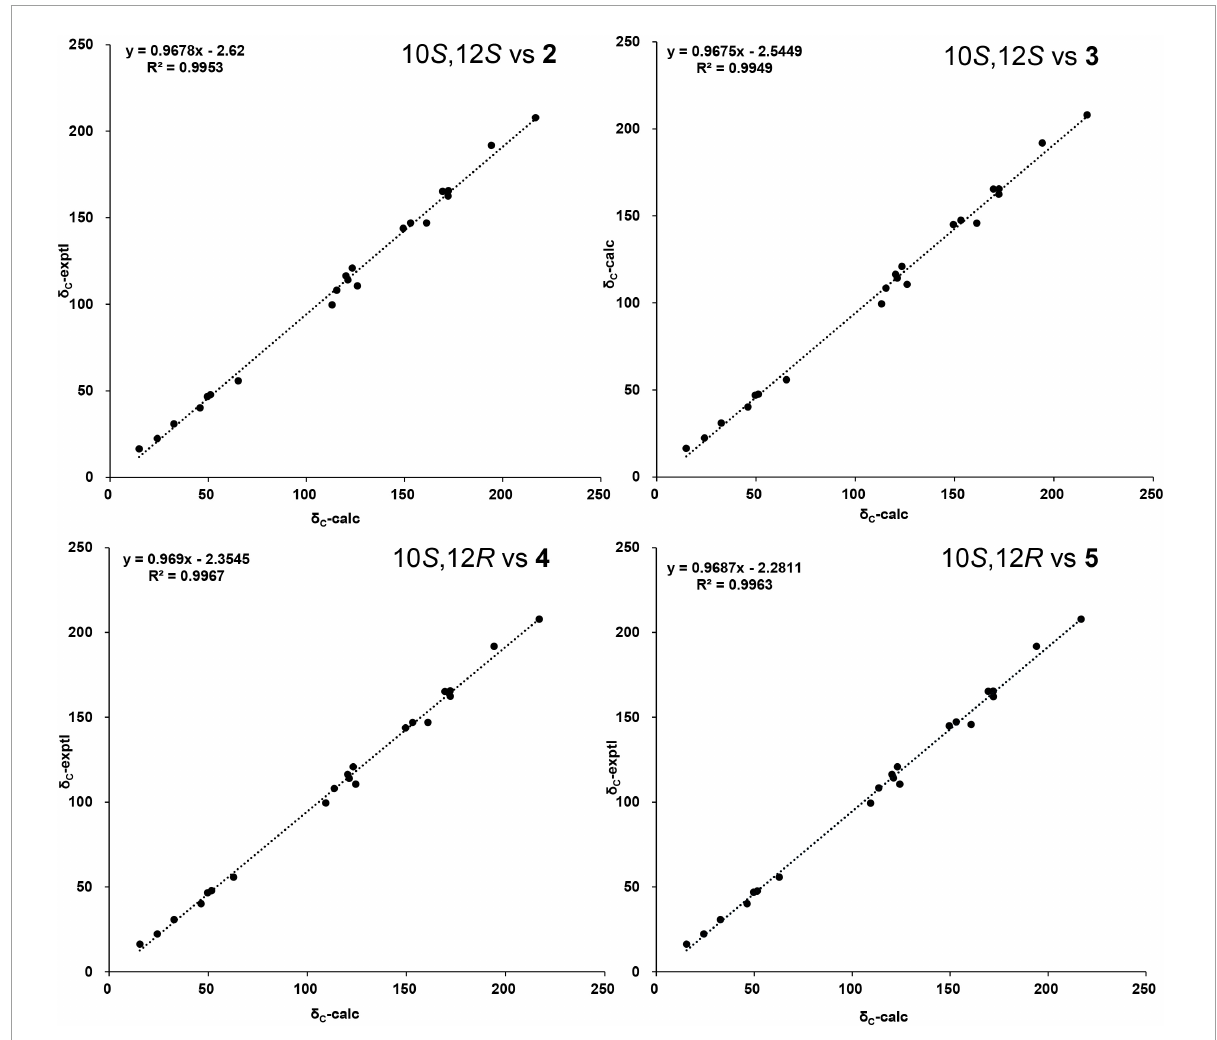
FIGURE6 The linear regression analysis of calculated and experimental nuclear magnetic resonance (NMR) data of (10,12)-stereoisomers and compounds 2 and 3 .